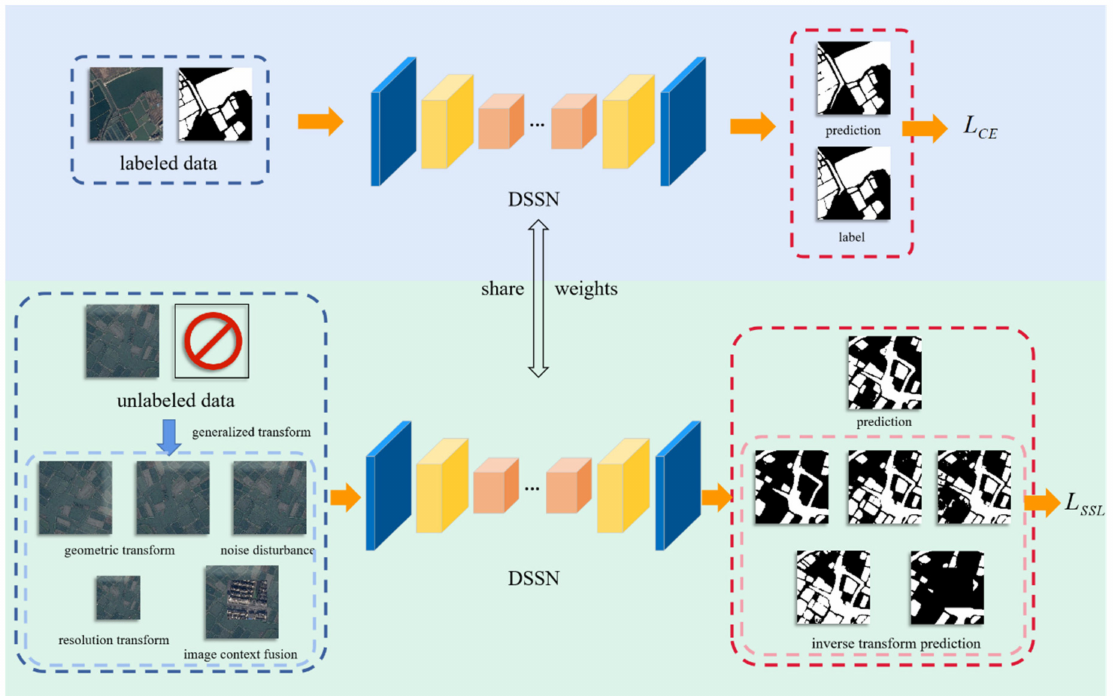
Figure 2. The workflow of the proposed SSL strategy, including geometric transformation learning, noise disturbance learning, image resolution learning and image context fusion learning. During the process of training, the total training loss contains supervised cross-entropy loss and SSL